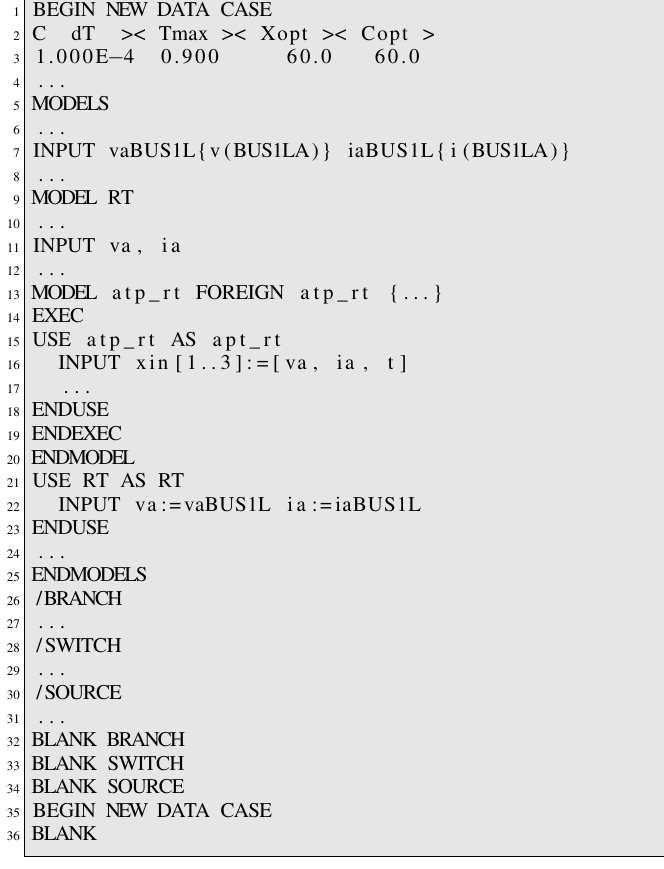
Figure 3. ATP file input